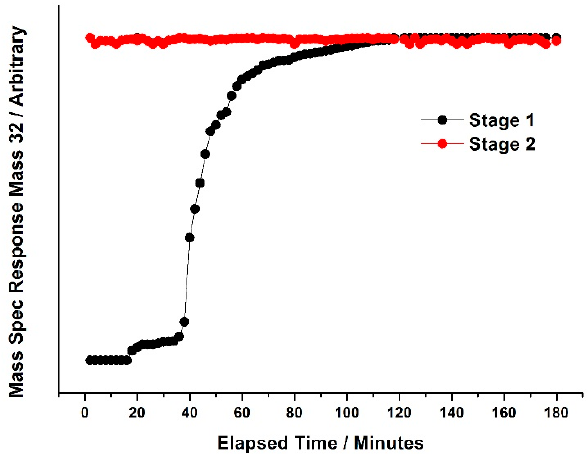
Figure 27. Oxygen pulsing study on reduced Fe 2 (MoO 4 ) 3 at 350 ˝ C, Stages 1–2. Post reductio, catalysts were subjected to pulses of 10% O 2 /He from a known sample loop volume every two minutes. The uptake of oxygen was monitored through the change in peak integral of Mass 32. Each stage consisted of 180 min of pulsing. By stage two, 100% O 2 saturation had